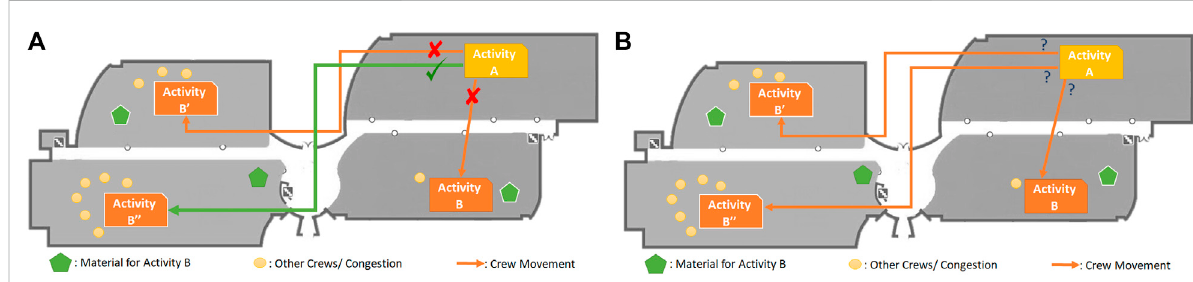
FIGURE 1 Crew logistics for moving between activities following (A) a push system and (B) a pull